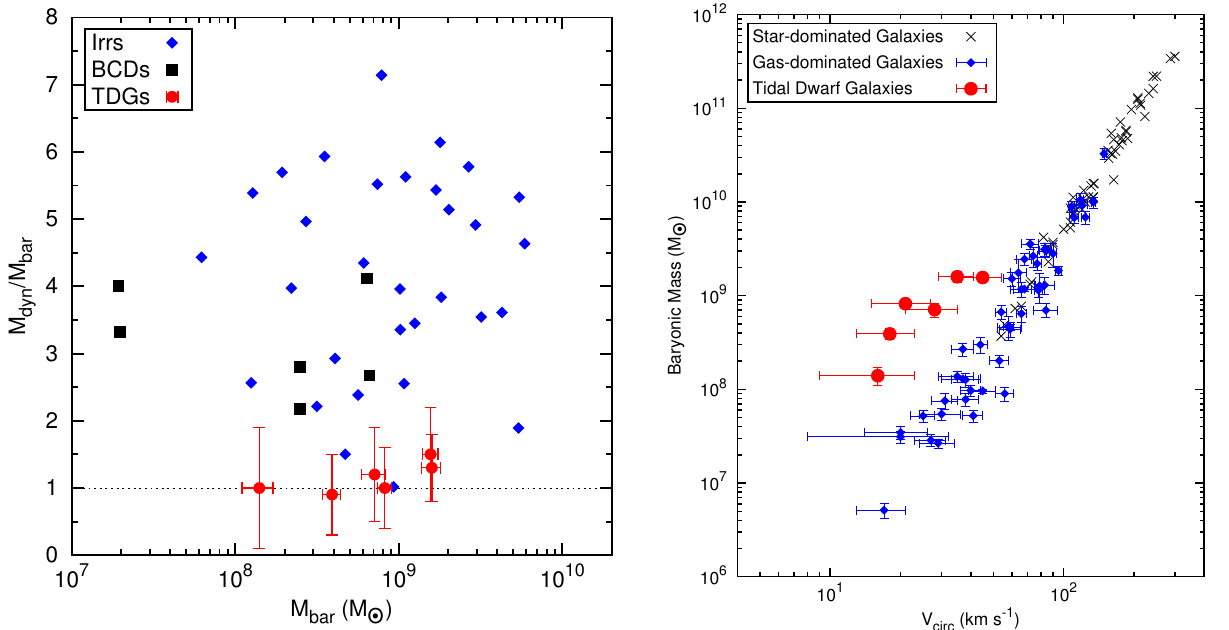
Figure 3. Left panel : Mass budget within the optical radius for different types of dwarf galaxies (see [13] for details). Right panel : Location of TDGs on the BTFR. V circular velocity after correction for pressure support. For typical galaxies, V along the flat part of the rotation curve [22,23]. For TDGs, the shape of the rotation curve is uncertain, thus V may not correspond to the velocity along its flat circ